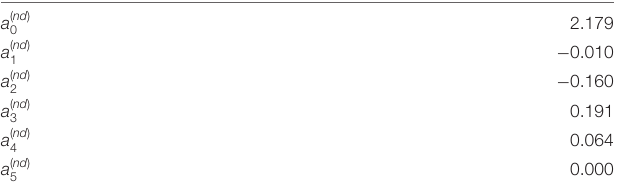
TABLE 9 | The same as in Table 8 but for the χ EFT NLO PVTC potential and the N 3 LO PCTC potential derived in Machleidt and Entem [